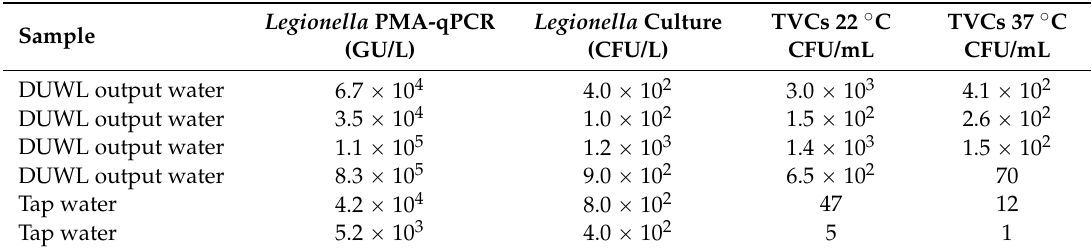
Table 2. Quantification of Legionella in the six culture-positive environmental water samples: comparison of the results obtained using the PMA-qPCR and culture methods and the TVCs.